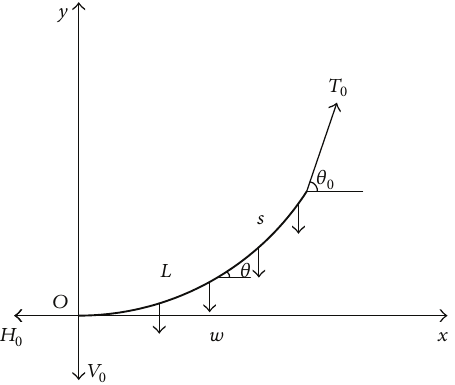
Figure 2: Mechanical parameters of the pipeline single point lifting and lowering model.